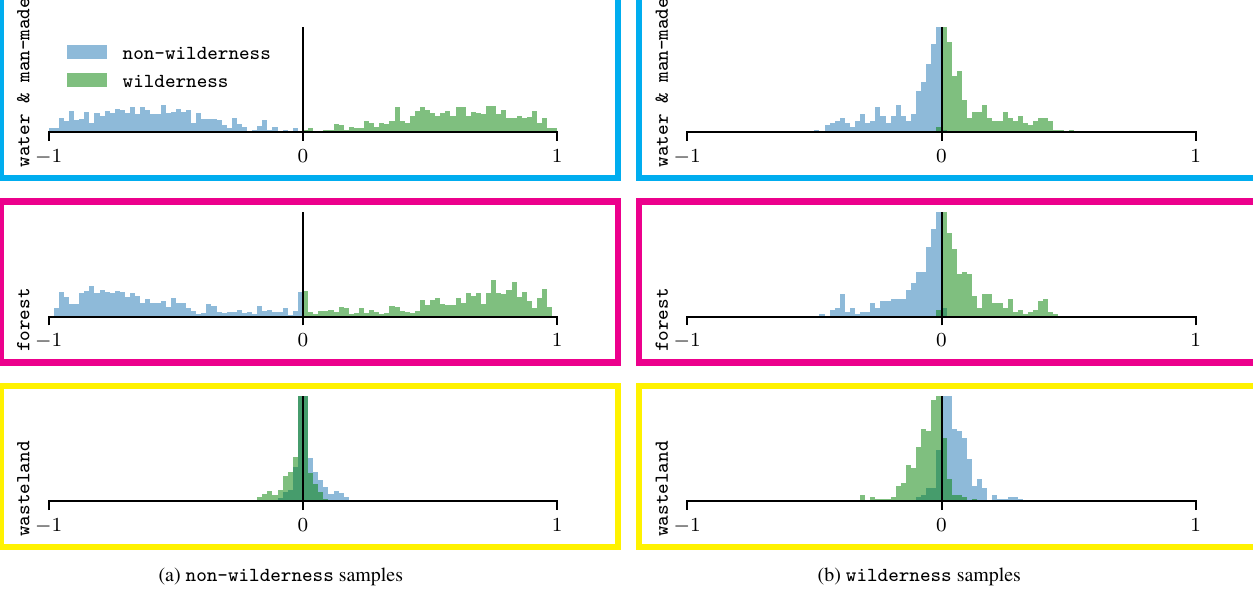
Figure 9. Confidence score deviations when covering image areas of different concepts. a) and b) show the effects for samples that are labeled non-wilderness and wilderness . Blue and green histograms show the changes to the non-wilderness and wilderness scores. The scores are more sensitive to the concepts of water & man-made and forest , and less sensitive to wasteland